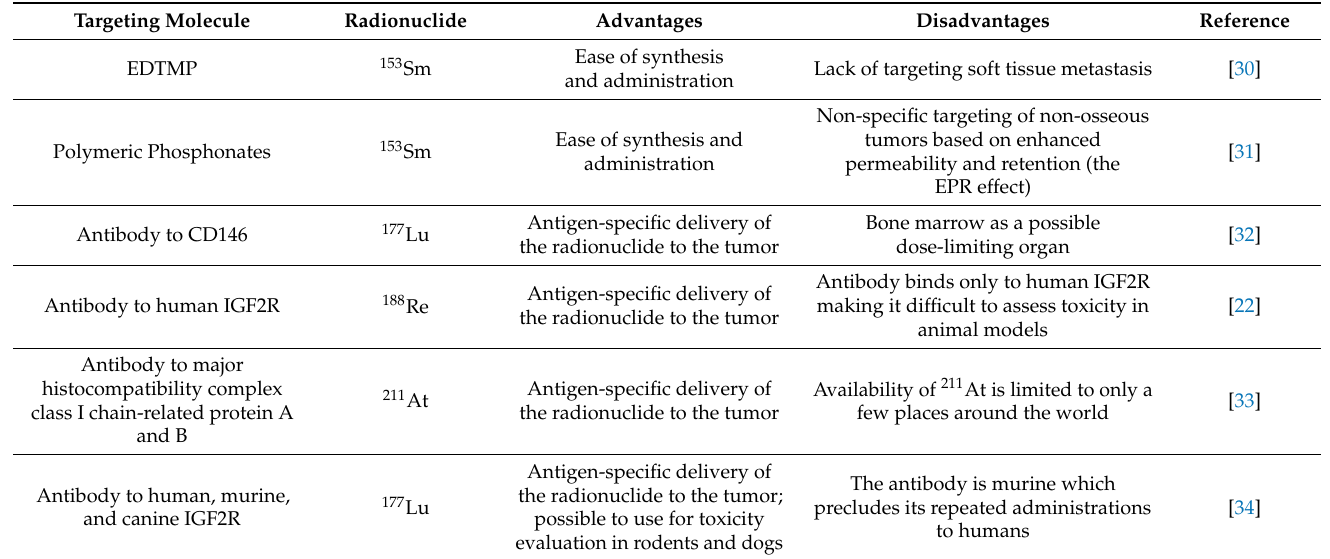
Table 1. Examples of TRT use for treatment of OS in experimental